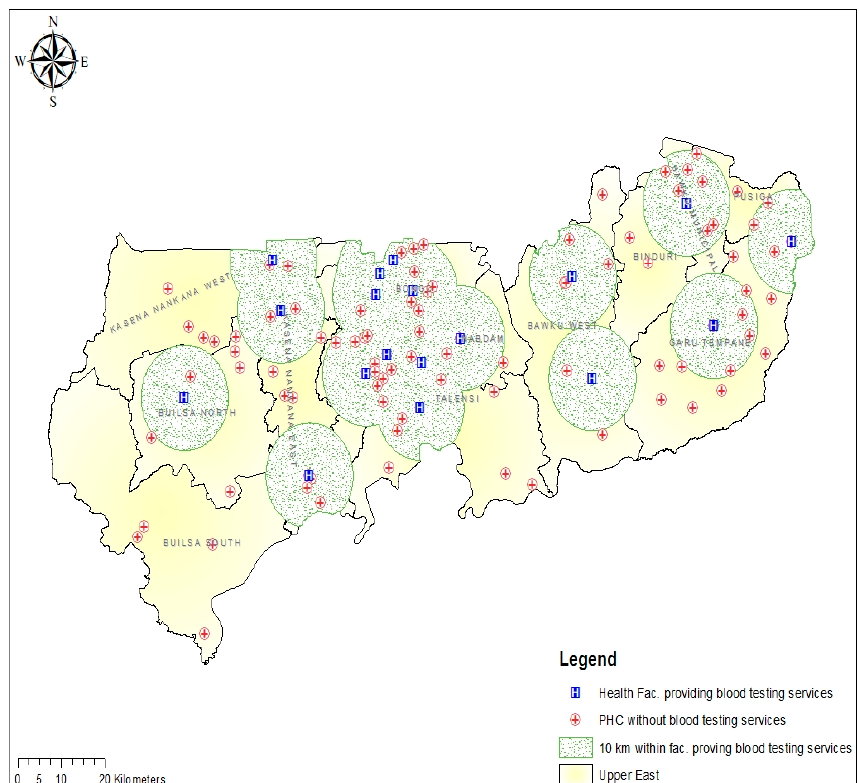
Figure 4. Map showing the distribution of the PHC clinics and distance within 10 km from the nearest health facility providing blood group and rhesus type testing services in the UER.